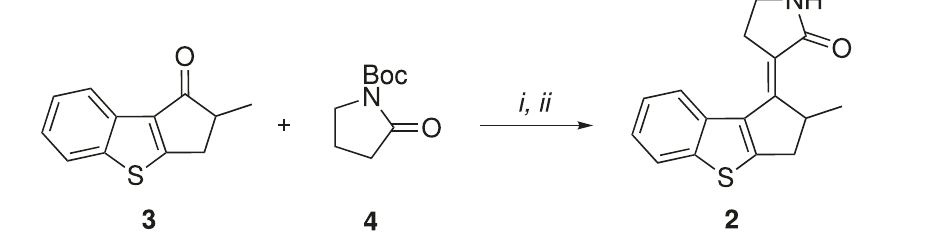
Fig. 5 | Synthesis of MTDP. Reagents and conditions: (i) LiHMDS, BF 3 ⋅ Et 2 O, THF dry, − 78°C; (ii) TFA, DCM, 0°C to room